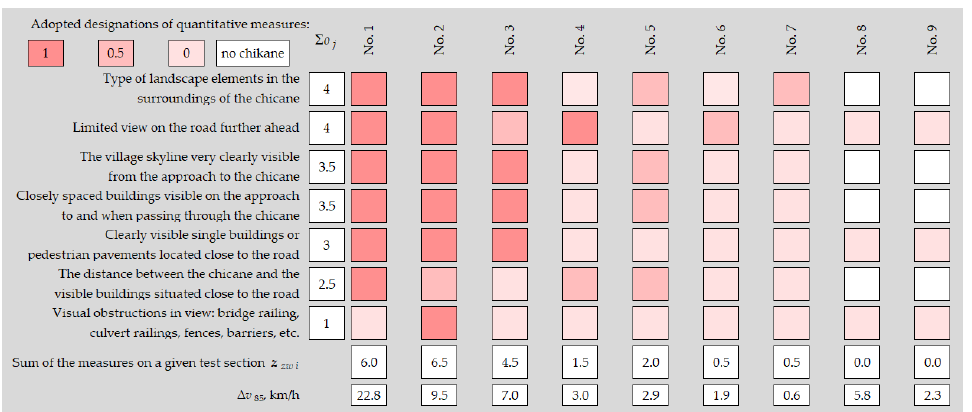
Figure 16. Outcomes of the assessment of the factors associated with the landscape and visibility criterion. Designations: o j — a subsequent factor in consideration, Σ o j — the sum of confirmed logical tautologies on the test sections in relation to the considered j -th factor, z zw i – the sum of quantitative measures in all factors on the i- th test section.